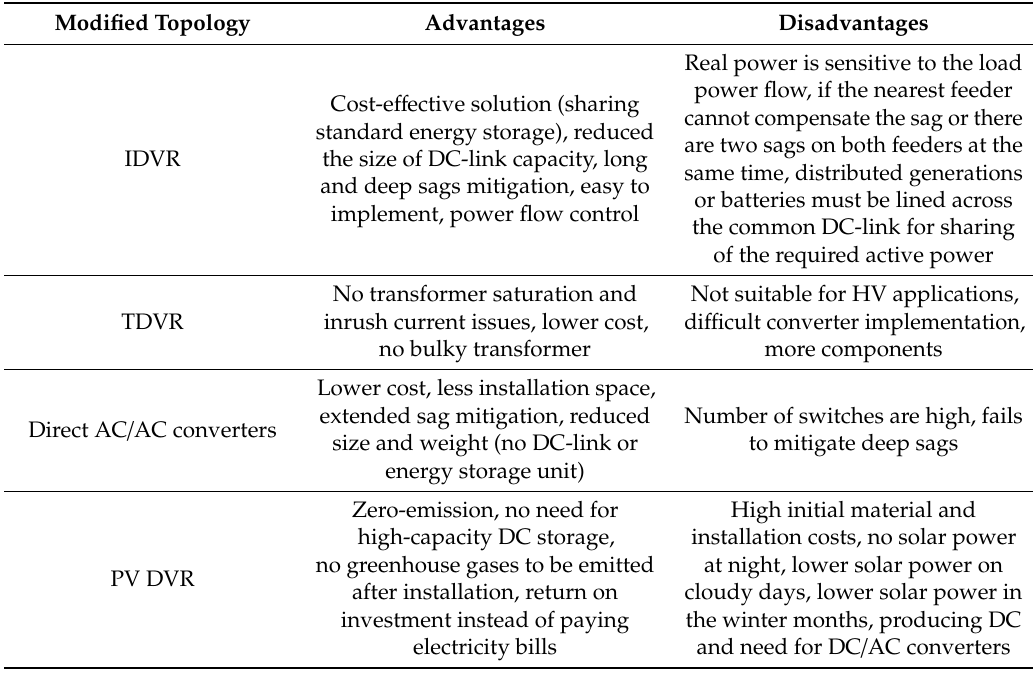
Table 10. Modified DVR topologies, along with their advantages and disadvantages. Based on data from